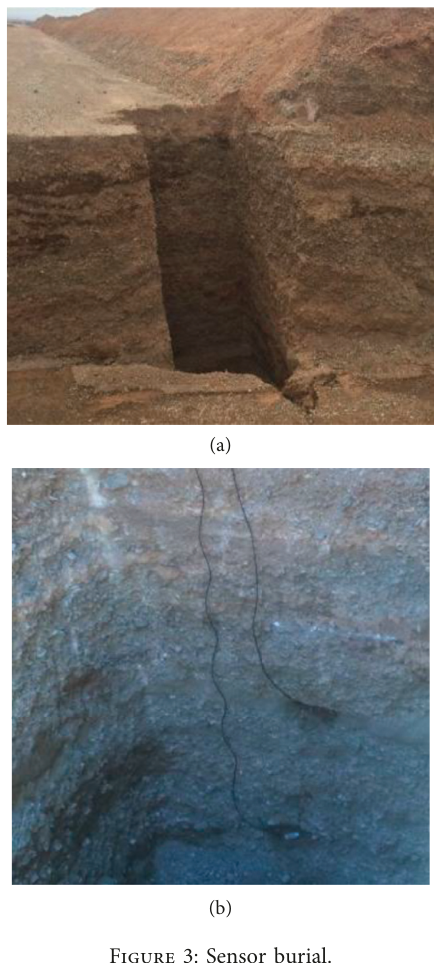
Figure 3: Sensor burial.